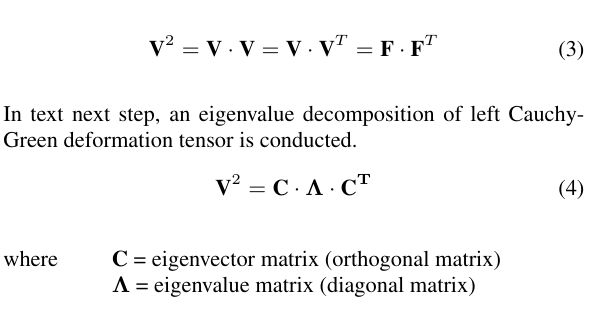
antee a reliable image template matching. During the experiment, an image sequence is recorded. The probe will develop a crack pattern with increasing load. The first image of the sequence is taken as reference image. In this image under zero load, points are defined on a regular grid or by applying an interest opera- tor, for instance the Harris operator (Harris and Stephens, 1988). The points in the subsequent images are tracked by Least Squares Initial values for the shifts can be obtained with normalized cross- correlation. The points are triangulated into a mesh using the De- launay algorithm (Figure 2). Each triangle is tested for changes in each time epoch by computing principal strains.